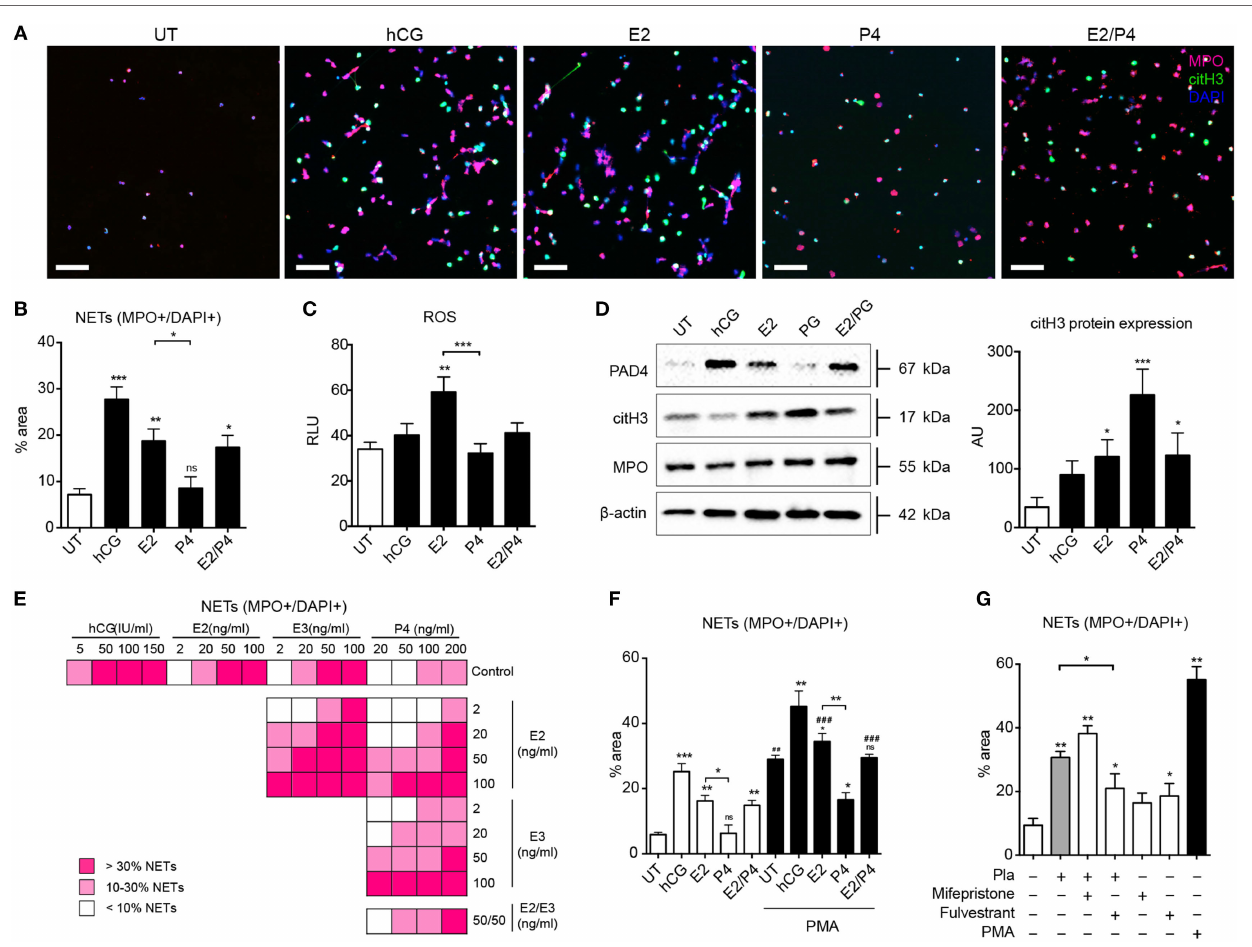
FigUre 3 | neutrophil in vitro pro-neTotic priming is regulated by pregnancy hormones . (a) Fluorescent immunocytochemistry of peripheral neutrophils after incubation with physiologic pregnancy concentrations of the sex hormones hCG (50 IU/ml), E2 (20 ng/ml), P4 (50 ng/ml), and the combination of 20 ng/ml E2 and 50 ng/ml P4 for MPO (red), citH3 (green), and DNA counterstain with DAPI (blue) after a 2-h in vitro culture. (B) Morphometric analysis of the NETotic (MPO + / DAPI + ) neutrophils from healthy control donors under the aforementioned hormonal in vitro treatment. (c) Oxidative burst in neutrophils from healthy control donors treated with physiologic pregnancy concentrations of hCG, E2, P4, and the combination of E2 and P4 for 3 h by DCFH-DA. (D) Western blot analysis of PAD4, citH3, MPO, and beta-actin protein expression levels in lysates from healthy female control neutrophils treated in vitro with the aforementioned concentrations of sex hormones. (e) Information graphic summarizing the in vitro spontaneous NET release monitored by dsDNA-binding fluorescent SytoxGreen dye in a 3-h time course after treatment with four ascending concentrations of each of the gestational hormones hCG, E2, E3, and P4, separately or in crosswise combinations. (F) Morphometric analysis of the NETotic (MPO + /DAPI + ) and pro-NETotic primed (citH3 + ) neutrophils from healthy non-pregnant donors after 1 h pretreatment with physiologic concentrations of hCG, E2, P4, and E2/P4 and stimulation with 25nM of the NET-inducing agent PMA as a second hit for additional 2 h in vitro . (g) Detection of in vitro spontaneous NET formation of neutrophils from healthy controls cocultured with pregnancy plasma pretreated with 10 μ g/ml of the specific inhibitors of the estrogen and progesterone receptors, fulvestrant and mifepristone (RU486), respectively, over a 3-h time course by fluorescence microscopy using morphometric analysis of the NETotic (MPO + /DAPI + ) and pro-NETotic primed (citH3 + ) neutrophils. Data are presented as mean ± SEM. * P < 0.05, ** P < 0.01, *** P < 0.001, and **** P < 0.0001 (one or two way ANOVA followed by Bonferroni’s multiple comparison post-test). All experiments were performed at least six times with consistent results. RFU, relative fluorescence units; Pla, pregnancy